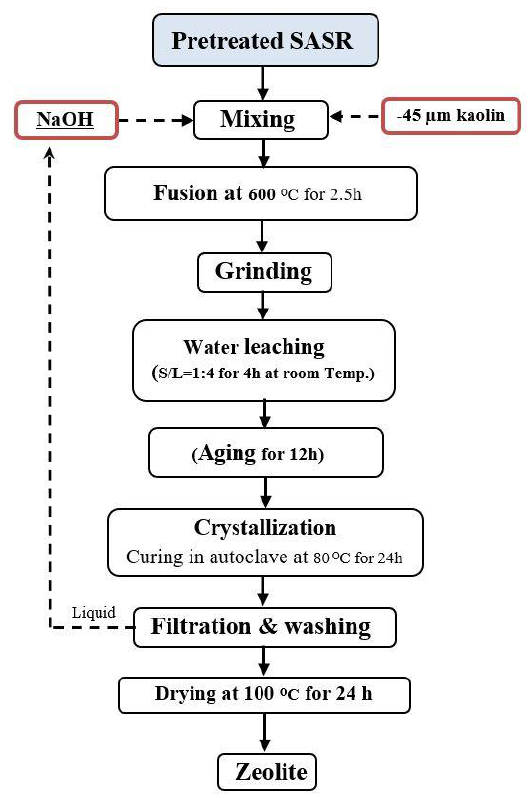
Scheme 1. Schematic flow diagram for synthesized zeolite based on mixture of SASR and kaolin concentrate using the alkali-fusion